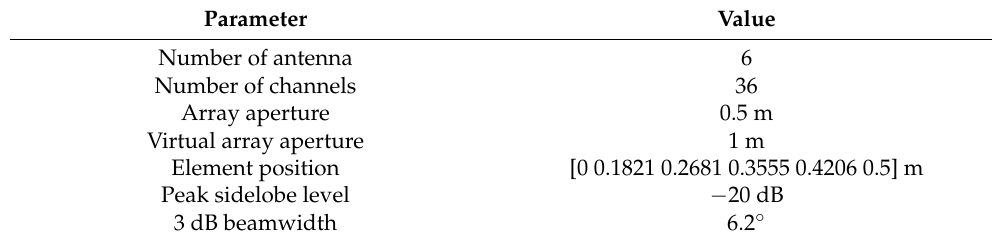
Table 2. Array parameters.